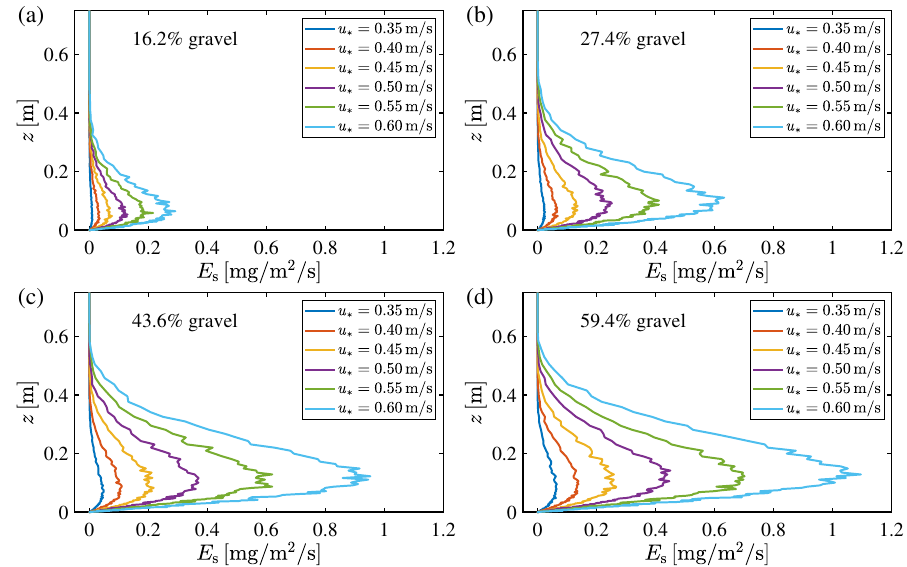
Figure 7. Vertical profiles of saltation erosion rate E s , corresponding to different friction velocity, for ( a ) on Gobi with 16.2% gravel coverage, ( b ) on Gobi with 27.4% gravel coverage, ( c ) on Gobi with 43.6% gravel coverage, and ( d ) on Gobi with 59.4% gravel coverage.